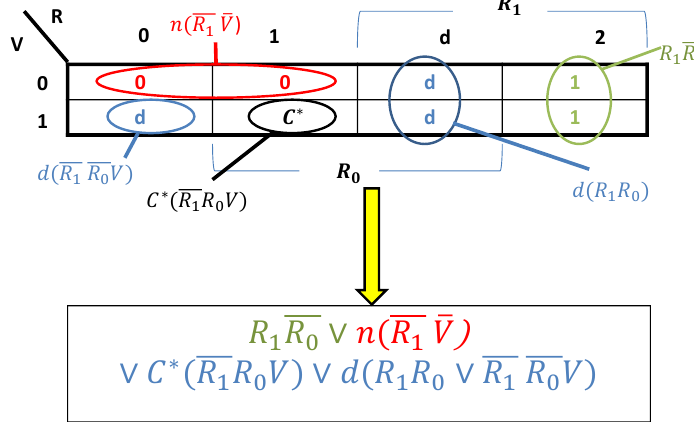
Fig. 10. Compaction of the conventional cell 𝑪 ̅̅̅ 𝑪 ̅̅̅𝑭 𝑭 ̅̅̅̅ in Fig. 3 to an entered one in Fig. 9 by drawing loops for each of the four entities {1, 0, C * , d}. Loops for a specific entity are possibly overlapping, but